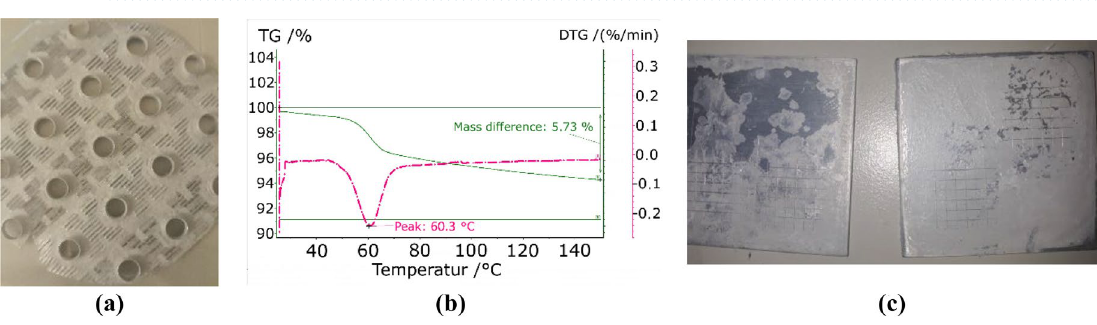
Figure 9. MgSO 4 coating with HEC: ( a ) fin, ( b ) TGA, ( c ) cross-cut test without (left) and with HEC (right).